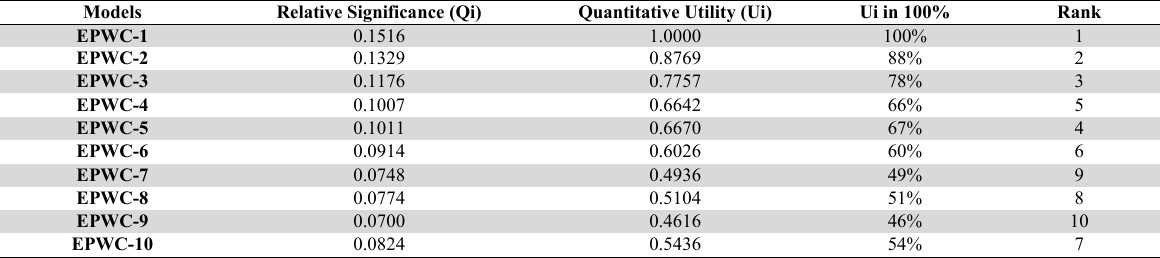
The Relative Significance and Quantitative Utility Values of Each